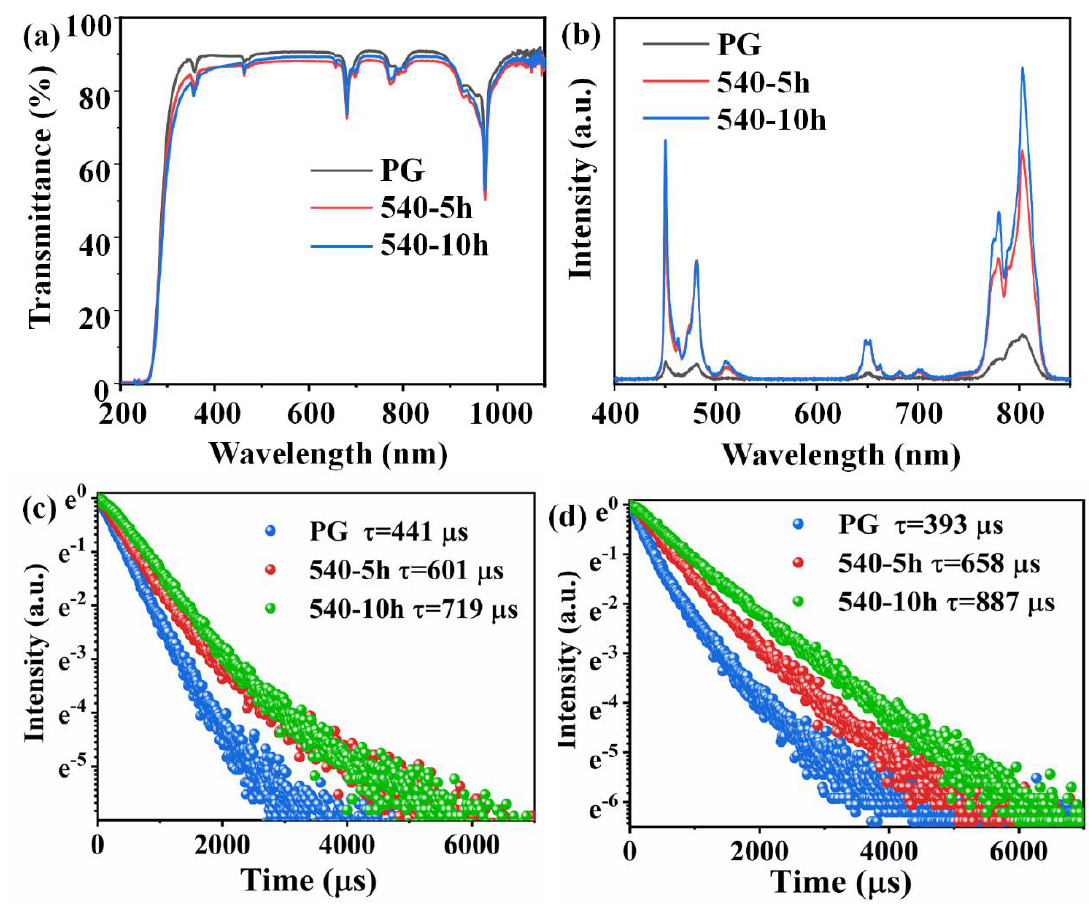
Figure 2. ( a ) Transmission spectra of 1.0Yb 3+ ‐ 0.1Tm co ‐ doped PG and GC. ( b ) UC emission spectra 1.0Yb 3+ -0.005Tm 3+ co ‐ doped PG and GCs. ( c ) Emission decay curves of 1.0Yb 3+ ‐ 0.005Tm 3+ co ‐ doped PG and GCs monitored at 450 nm emission. ( d ) Emission decay curves of 1.0Yb 3+ ‐ 0.005Tm 3+ co ‐ doped PG and GCs monitored at 802 nm emission.